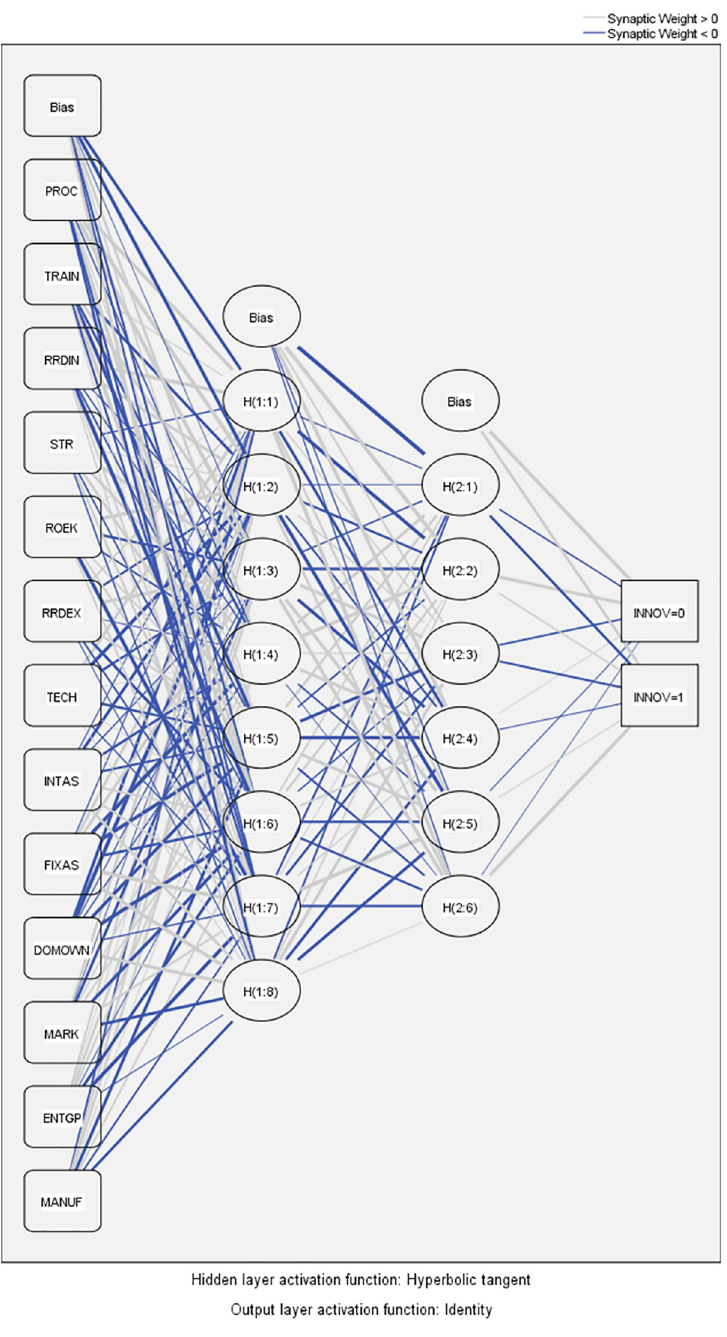
Fig 4. Artificial neural network diagram–Model